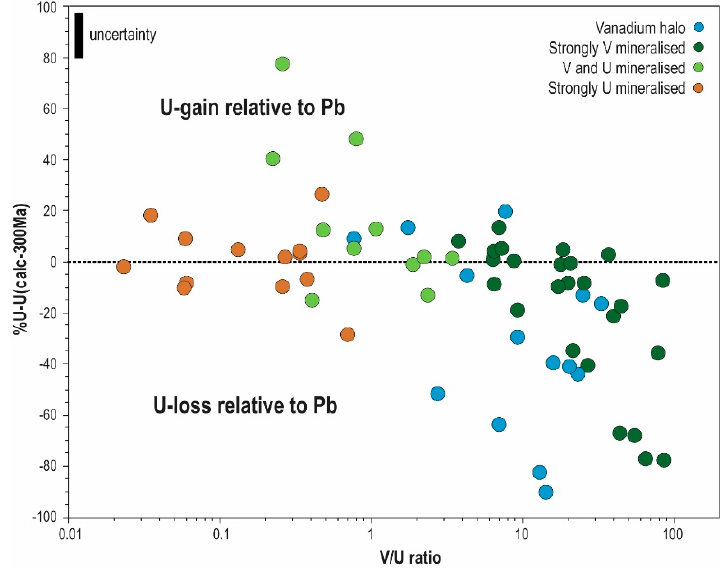
Figure 14. Percent deviation of uranium concentration from that expected for 300 Ma of closed system uranium decay, based on the concentration of present-day radiogenic Pb plotted versus sample V/U ratio. Data points are categorized by mineralization type as in Table 1. Samples showing time-integrated U-loss relative to Pb (i.e., samples with radiogenic Pb unsupported by current U levels) plot below the 0% line, and mainly comprise those from the vanadium halo and from strongly V-mineralized zones.